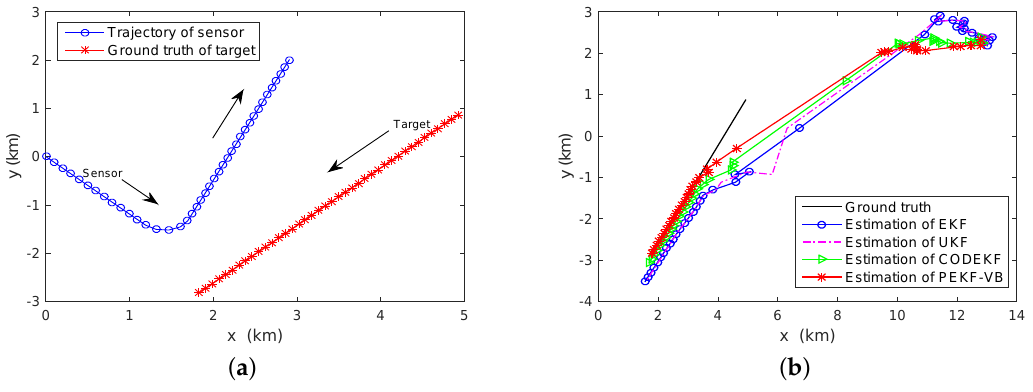
Figure 5. Bearing-only tracking. ( a ) Tracking scenario ( b ) Estimation obtained by EKF, UKF, CODEKF and